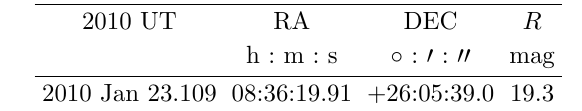
Table 1. The discovery time and position of 2010